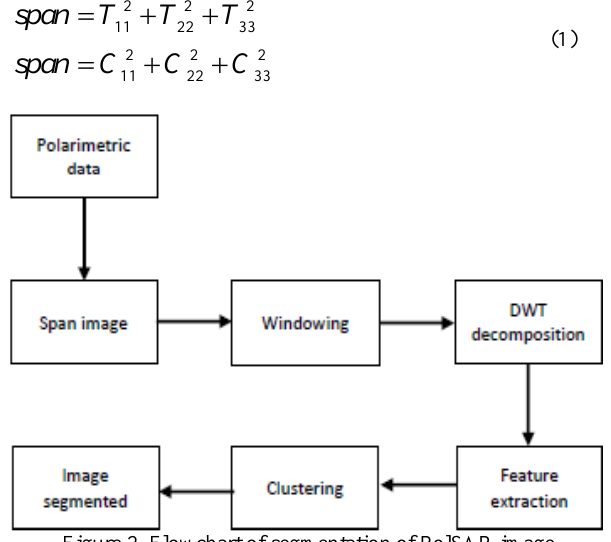
Figure 2. Flowchart of segmentation of PolSAR